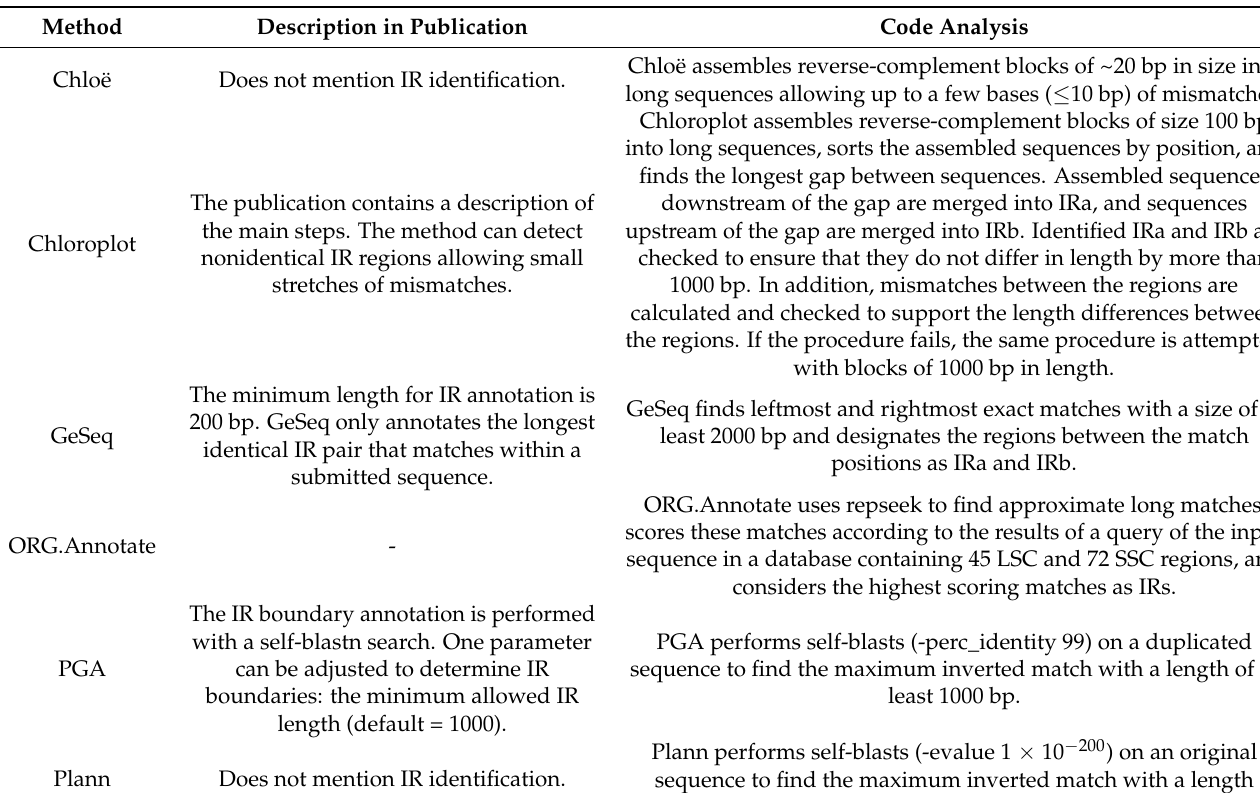
Table 1. The description of IR identification strategies implemented in six chloroplast annotation tools presented in publications and derived from code